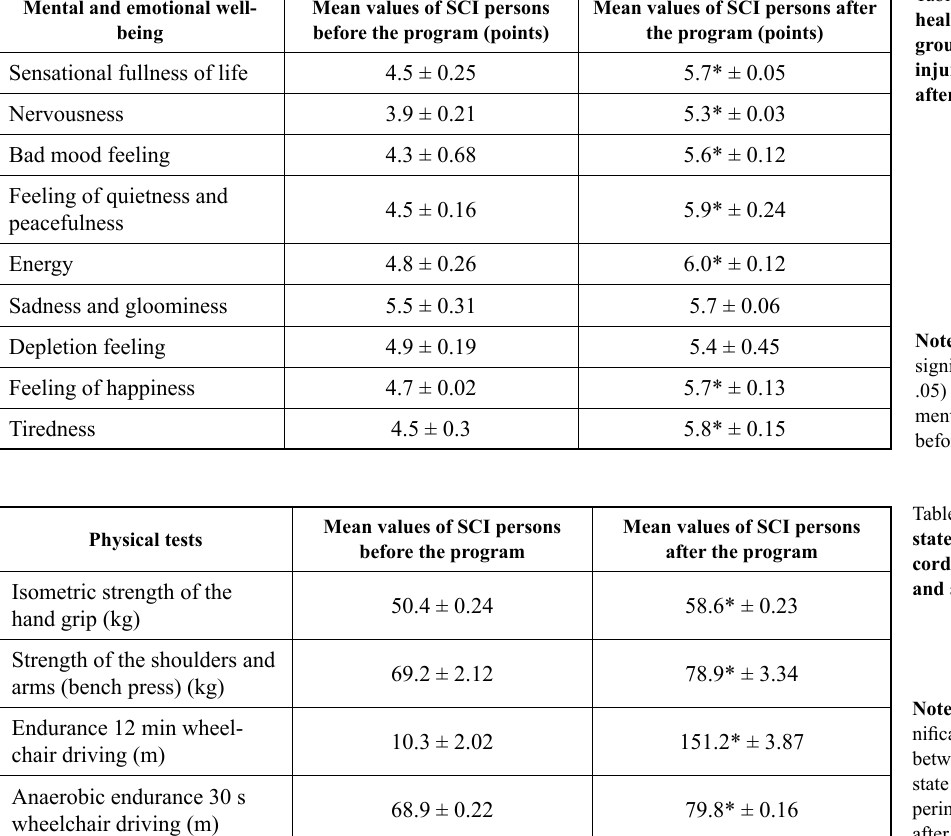
Table 1. Values of mental